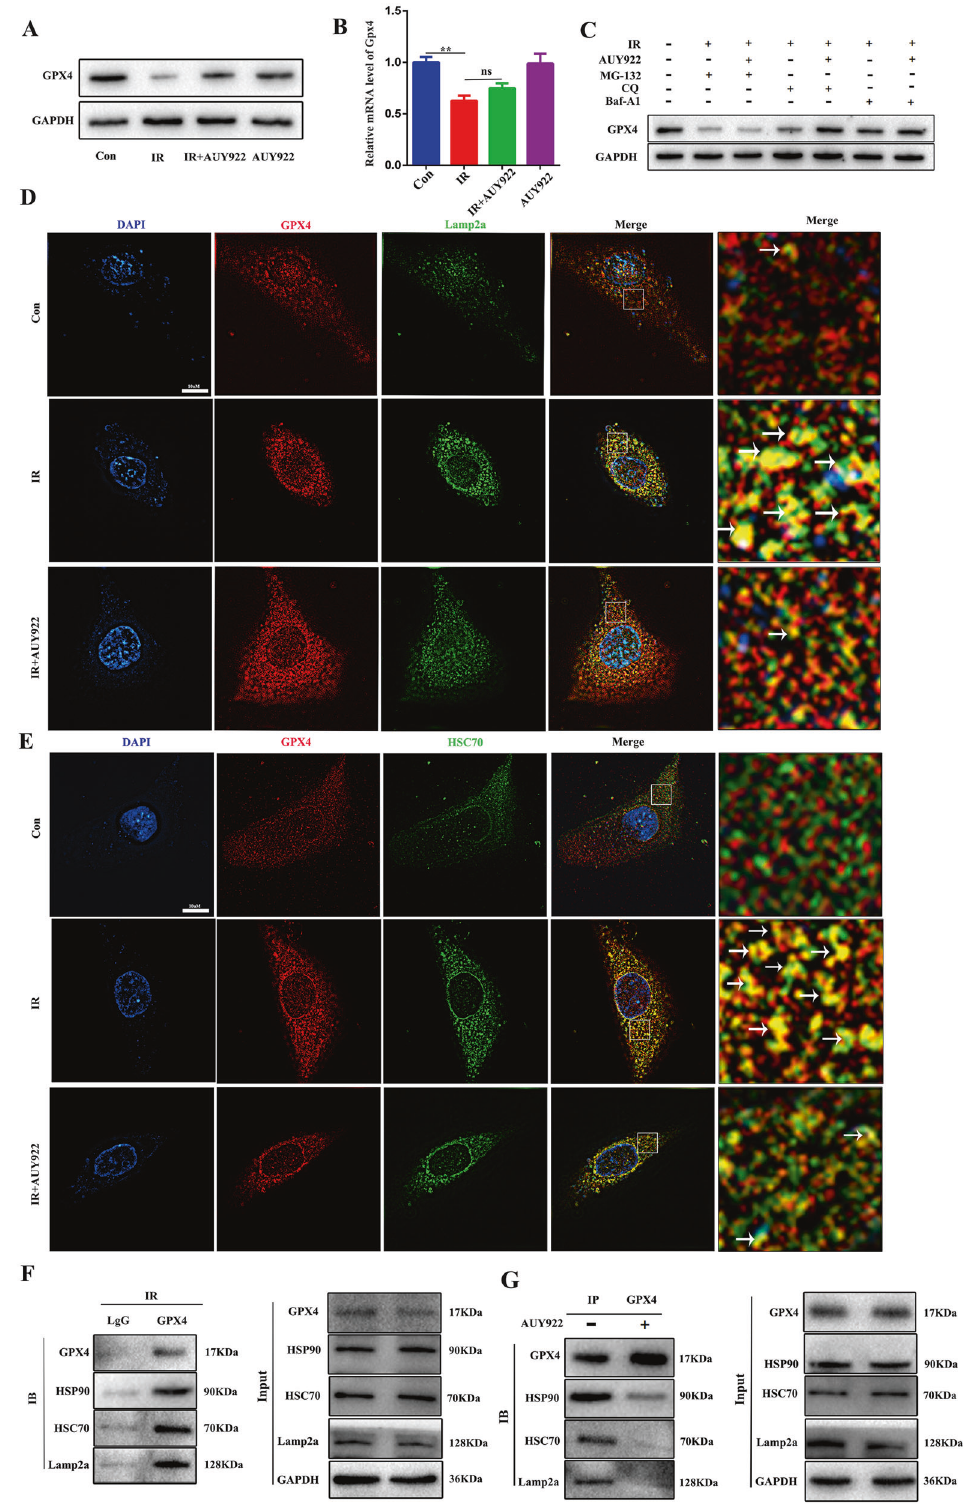
Fig. 6 NVP-AUY922 inhibited the interaction between GPX4, HSC70, and LAMP-2A induced by IR. A Western blot assay for GPX4. B Quanti fi cation of GPX4 mRNA levels by qPCR. C Western blot using an antibody against GPX4. BEAS-2B cells were pre-treated with MG132 (10 µM), CQ (25 µM), NVP-AUY922 (10 nM) and Baf-A1 (200 nM) 2 h prior to the 15 Gy radiation for 10 min. D – E Microscopy was performed to detect the changes in GPX4, HSP90, and LAMP-2A. F Co-IP assay was performed using an antibody against GPX4 or control IgG and western blotting for GPX4, LAMP-2A, HSC70, and HSP90 was performed. G Co-IP assays were performed using an antibody against GPX4 or control IgG followed by western blotting for GPX4, LAMP-2A, HSC70, and HSP90. #/ * P < 0.05, ##/ ** P < 0.01, ###/ *** P < 0.001, # vs. IR group; * vs. control group.